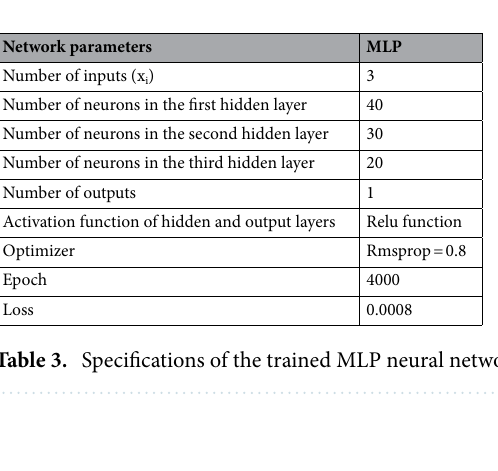
Figure 5. The appropriate configuration of the trained model of the MLP neural network for the 300 data of K value with three variables.